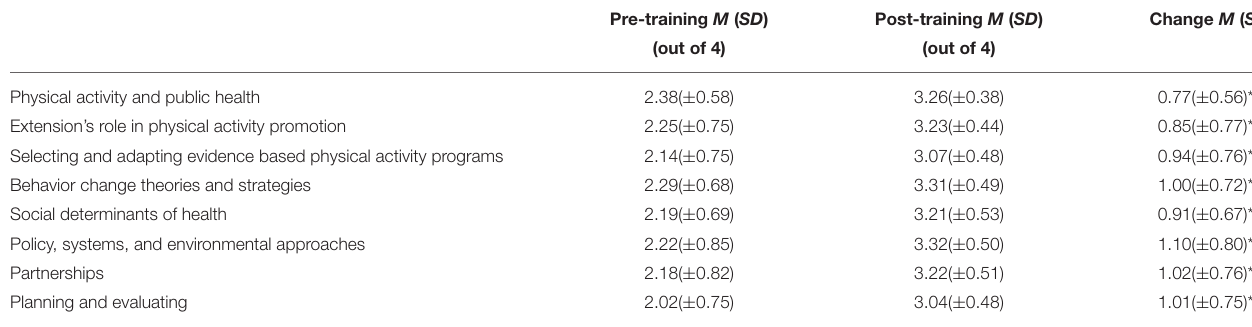
TABLE 2 | PACE participant pre- and post-change scores for the extension-based physical activity and public health competencies ( n =